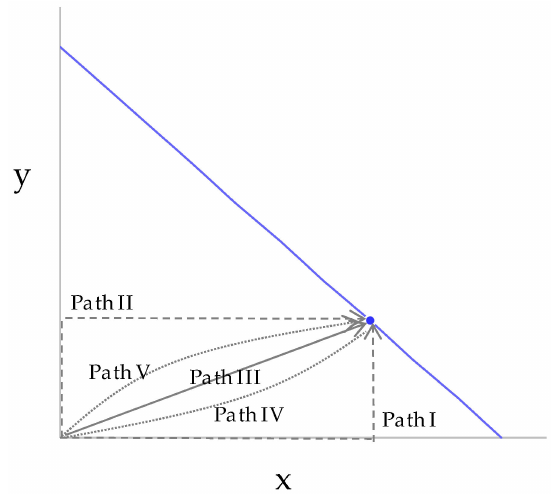
Figure A7. Integration paths for cost allocation.